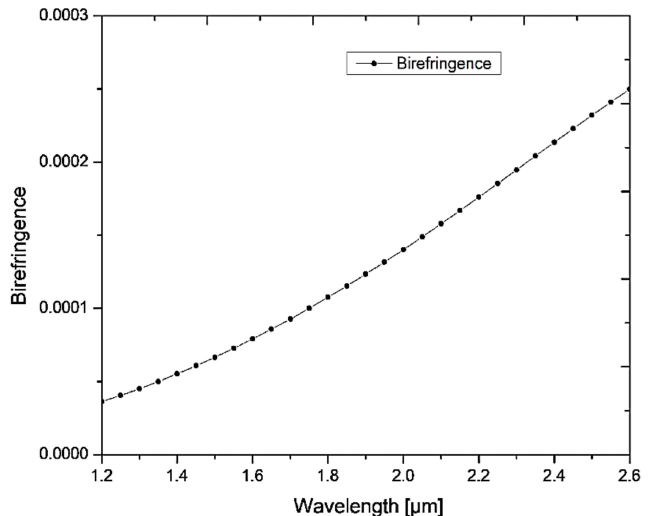
Figure 2. The birefringence vs wavelength of the proposed fiber without silver lining and analyte.